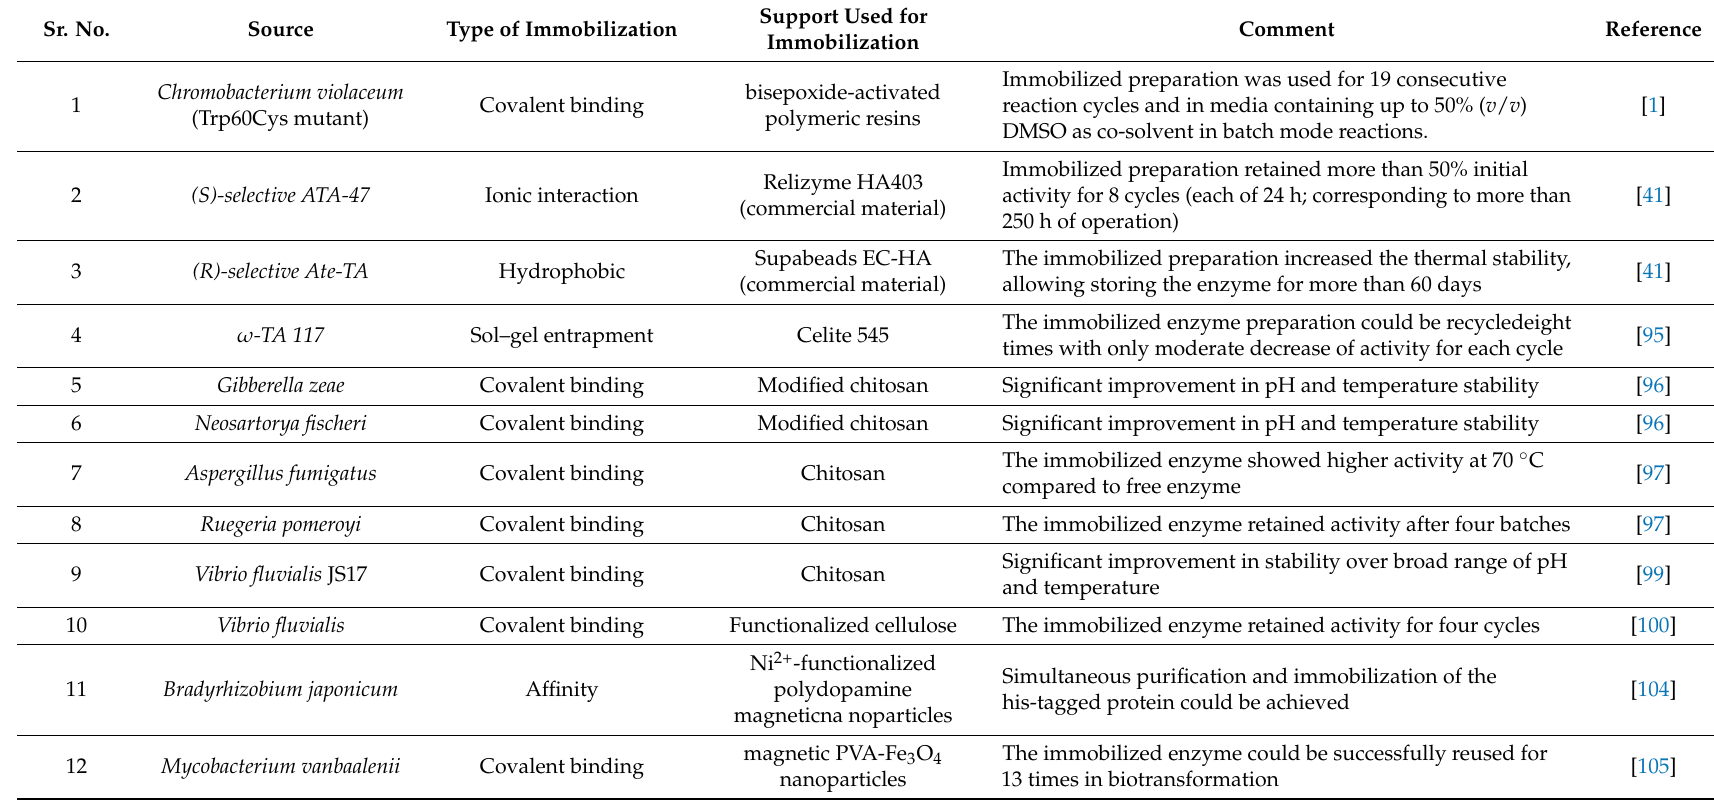
Table 3. Selected examples of immobilization techniques used to improve the operational stability of ω -TAs. Sr.